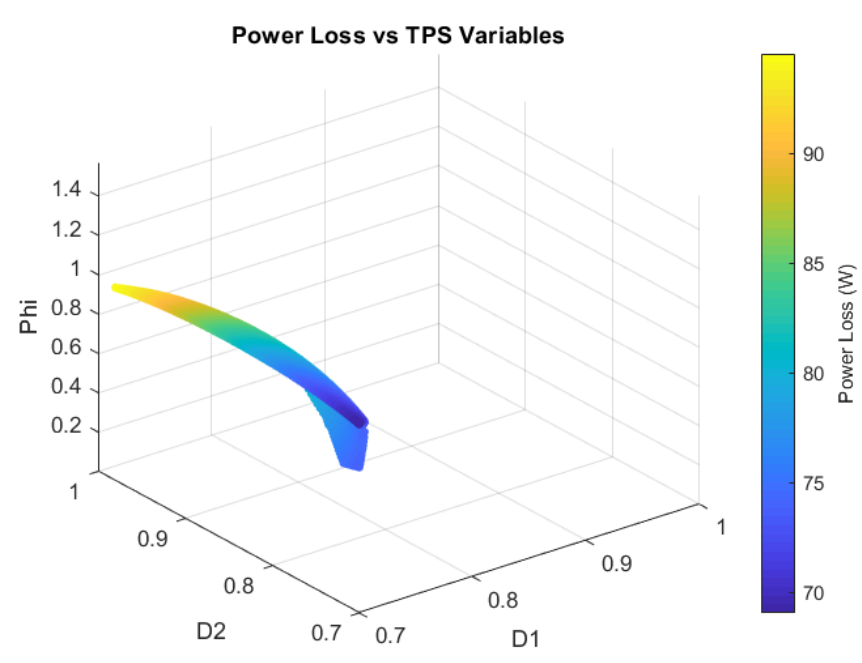
Figure 7. Optimal control variables vs. power losses.